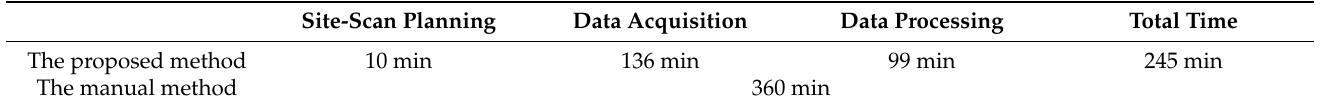
Table 5. Time comparison between the detection method proposed in this paper and the manual measurement